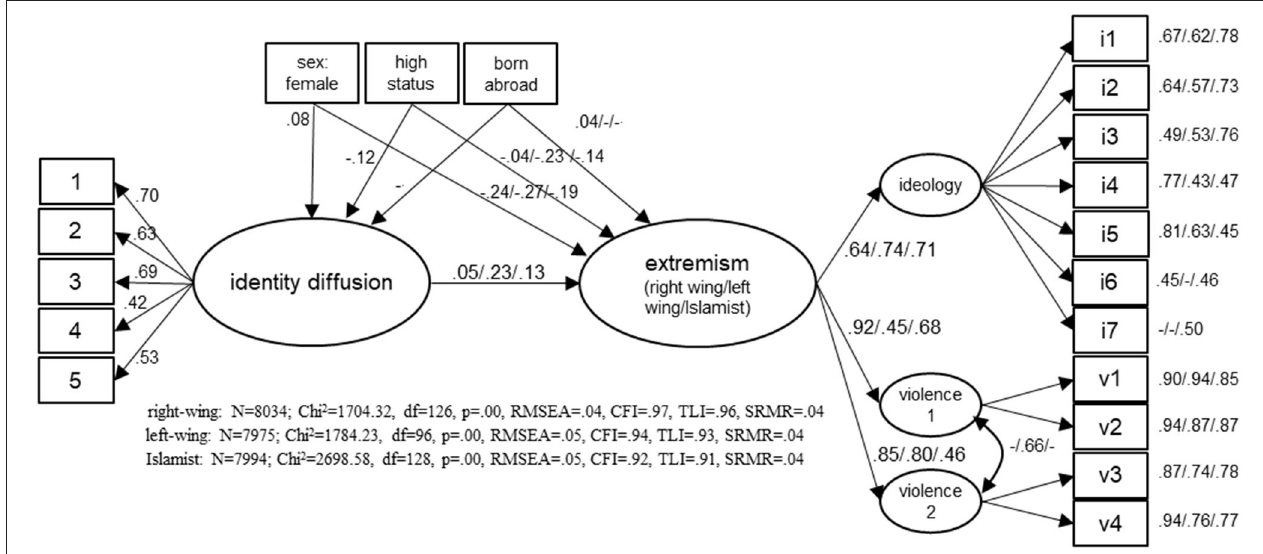
FIGURE 1 | Model to explain extremist attitudes by identity diffusion. Displayed: standardized coefficients; estimation procedure: Maximum Likelihood; order of displayed coefficients: left coefficient: right-wing extremism/medium coefficients: left-wing extremism/right coefficients: Islamist extremism; all coefficients significant at p < 0.05; “–” coefficient not significant at p <